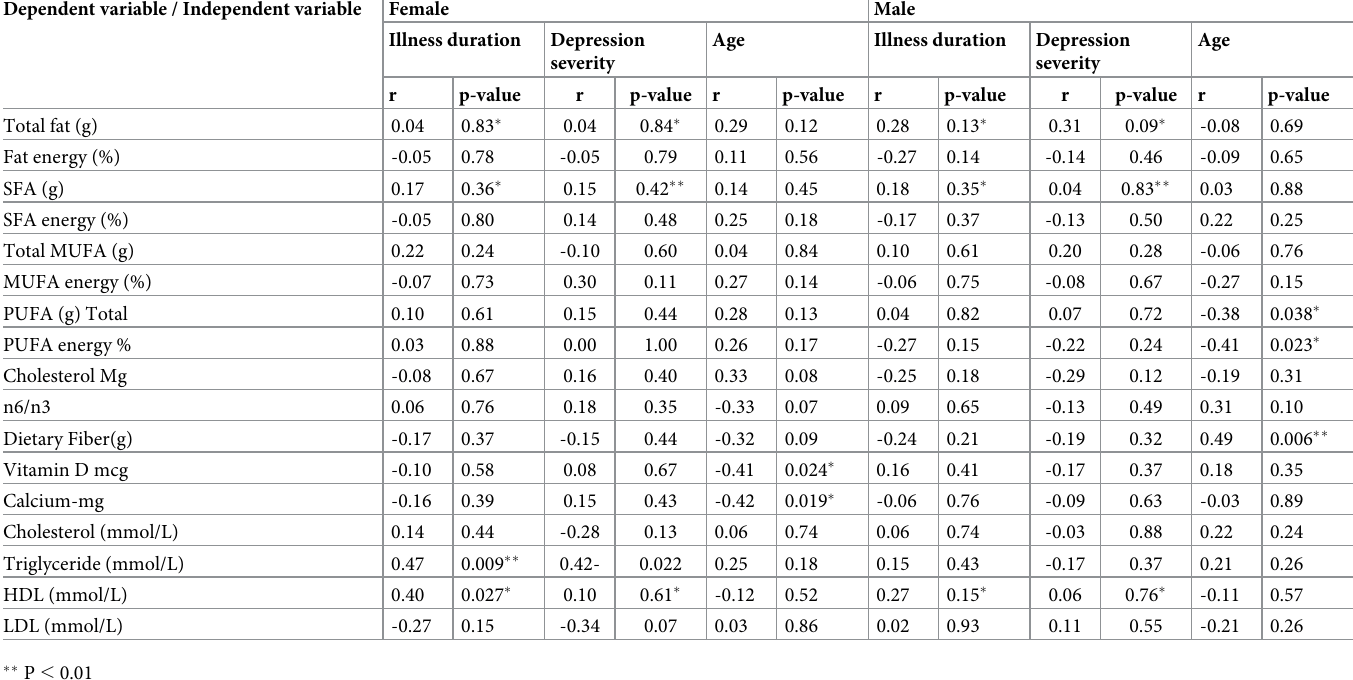
Table 5. Spearman correlation between nutrients intake, serum lipid parameters and duration of illness, the severity of depression (PHQ-9), and age of depressed respondents. Dependent variable / Independent